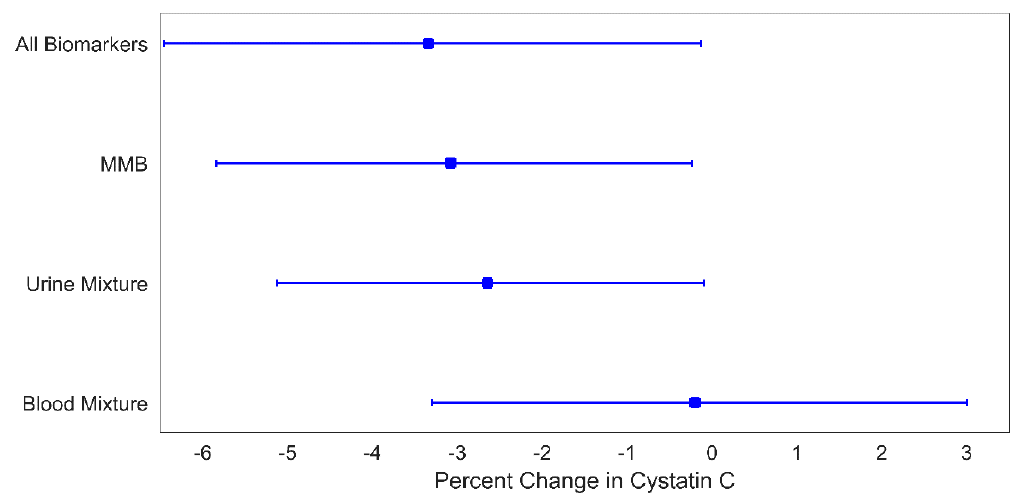
Figure 4. Percent change in cystatin C for a 1-quartile increase in metal mixtures levels. Plotted points are beta coefficients and lines are 95% confidence intervals. All models were adjusted for child age (years), child sex, indoor tobacco smoke exposure (referent group: no), SES (referent group: lower), and BMI (referent group: BMI z-score < 1). The p-values for these associations are: 0.04 (all biomarkers), 0.03 (MMB), 0.04 (urine mixture), and 0.90 (blood mixture). Table 5. Weights highlighting the contribution of each metal to the mixture effect of metals on Cystatin C. Larger weights indicated higher contributions to the mixture effect.